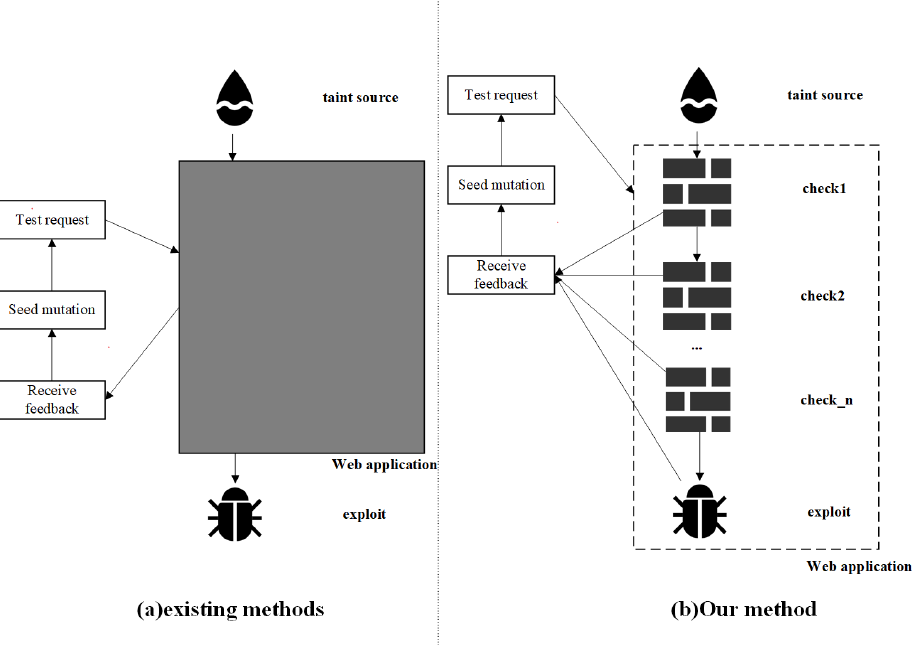
Figure 2 . Comparison of our method with existing